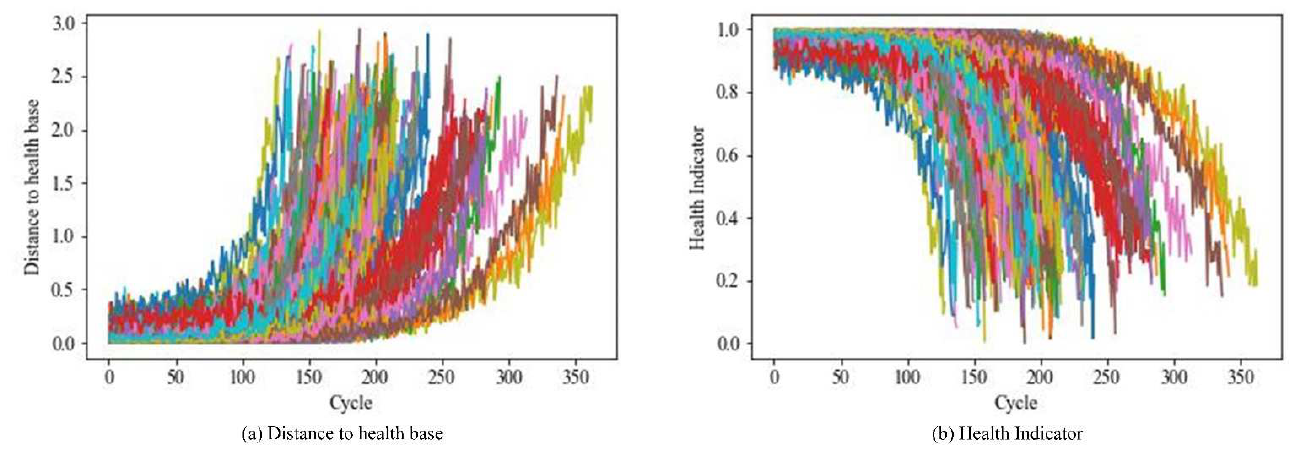
Figure 10. Distance to health base and health